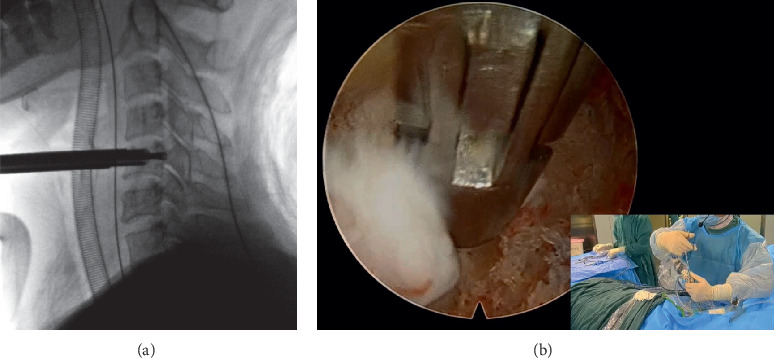
(a) Intraoperative fluoroscopy shows that the working cannula has been satisfactorily assembled. (b) The herniated disc is removed by the endoscopic rongeur under endoscopy.